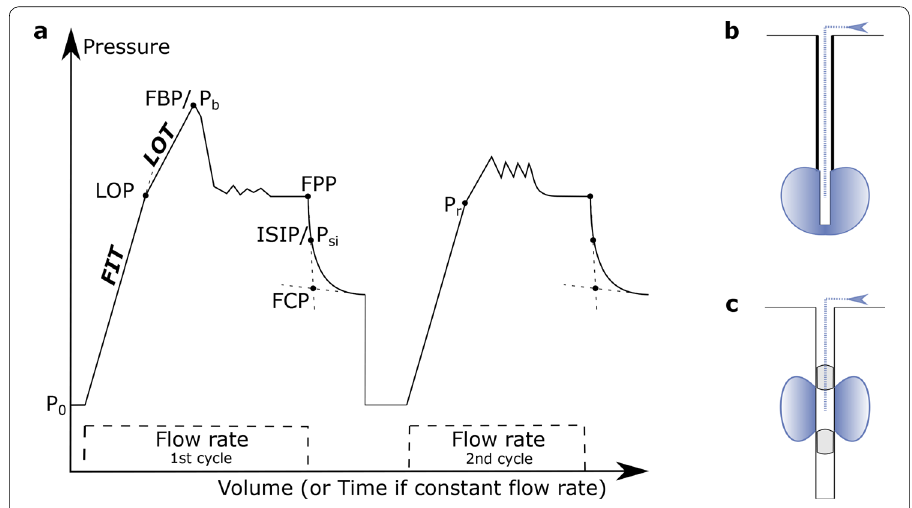
Fig. 3 Hydraulic pressure curves. a Schematic pressure curve of fluid injection tests (after White et al. 2002). FIT marks the stage in which the pumping is ceased in case of formation integrity tests, LOT marks the corresponding stage for leak-off tests. The continued curve is valid for hydraulic fracturing, mini-fracs and extended leak-off tests (XLOT). The pressure values to be picked are abbreviated as follows: LOP leak-off pressure, FBP / P b formation breakdown pressure, FPP formation propagation pressure, ISIP/ P si instantaneous shut-in pressure, FCP fracture closure pressure, P r reopening pressure. P 0 is the pore pressure prior to pumping. b Schematic setup of (X)LOTs and FITs at the uncased bottom section of a borehole. c Schematic setup of hydraulic fracturing and mini-frac procedures in a packed borehole